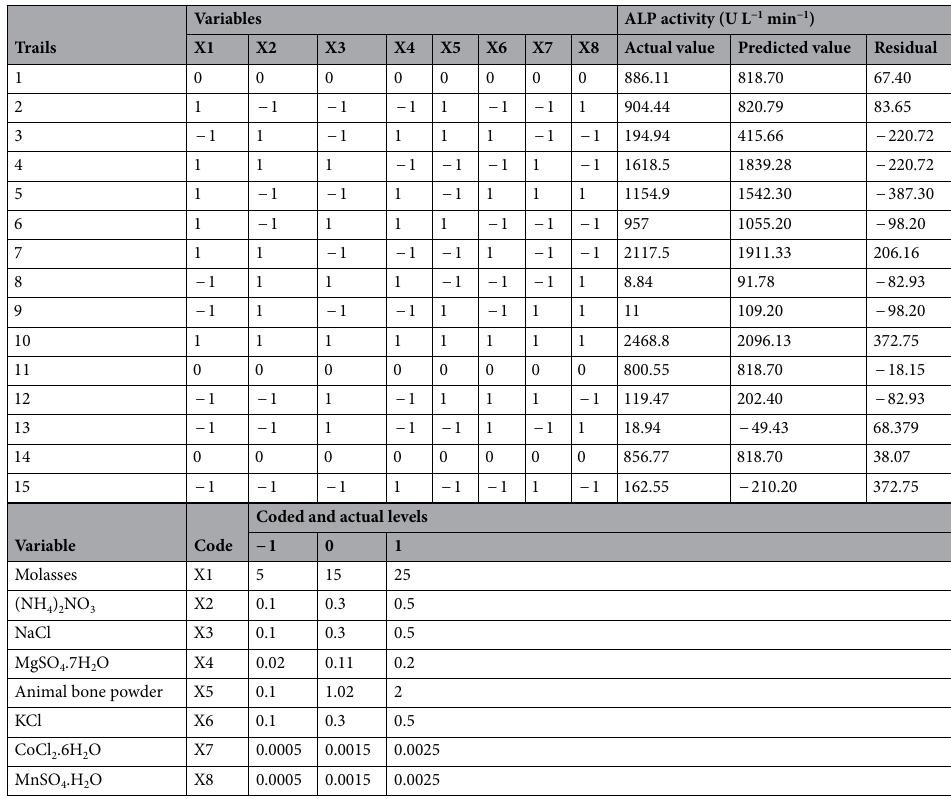
Table 1. Randomized PBD for evaluating factors influencing ALP production by Bacillus paralicheniformis strain APSO.